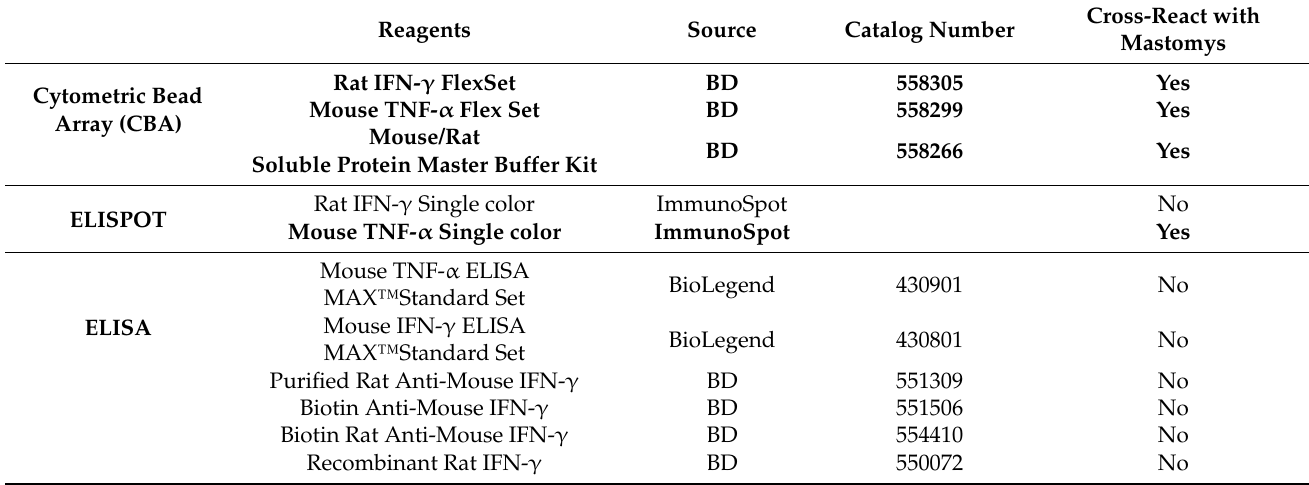
Table 2. Commercial kits used for the detection of cytokines produced by Mastomys-derived splenic